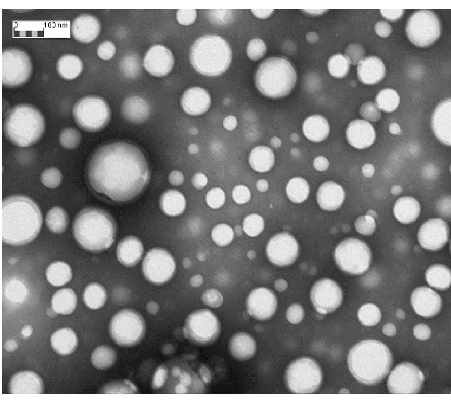
Figure 1. TEM photomicrograph of DXM loaded GE11-PLGA/PEG-PLGA blend NPs (Batch #DXM5). Magnification: 50,000×.